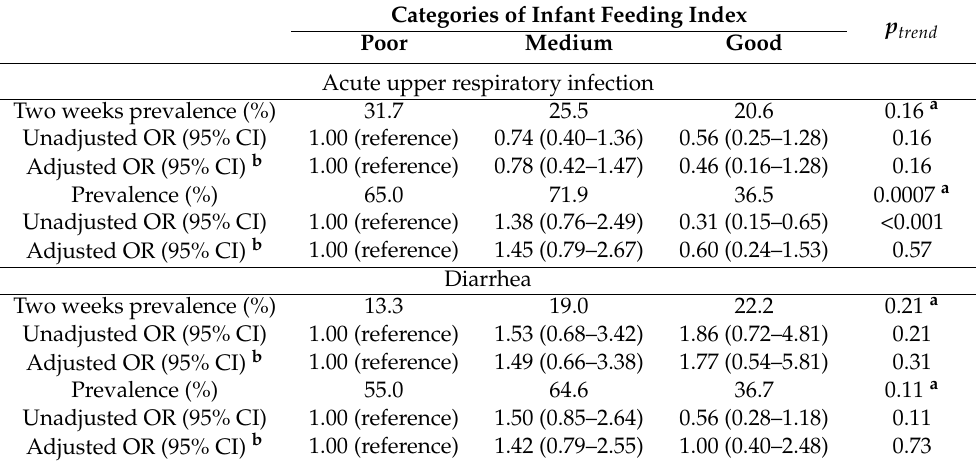
Table 5. Disease status as related to three categories of feeding practices index. Categories of Infant Feeding